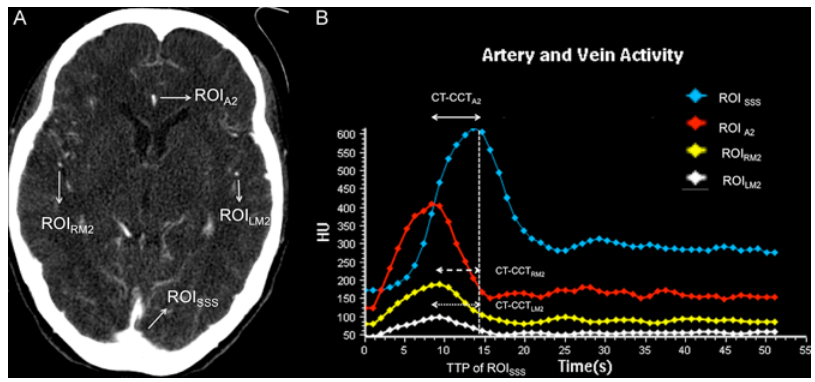
Fig 2. Axial view of the time-maximum intensity projection CTP and the time density curve of ROI. (A) An axial view of the time-maximum intensity projection CTP at the level where the ACA curved anteriorly and posteriorly. ROI A2 was chosen at the dominant ACA; ROI RM2, ROI LM2, and ROI SSS were designated at the corresponding vessels. (B) Time density curve of ROI A2, ROI RM2, ROI LM2, and ROI SSS. The dashed line intersected perpendicularly with the X-axis indicated the TTP of SSS. The CT-CCT A2 (double headed line) was defined as the time difference between the TTP of ROI A2 and that of ROI SSS ; The CT-CCT RM2 (dashed double headed line) was defined as the time difference between the TTP of ROI RM2 and that of ROI SSS . The CT-CCT LM2 (dotted double headed line) was defined as the time difference between the TTP of ROI LM2 and that of ROI SSS .